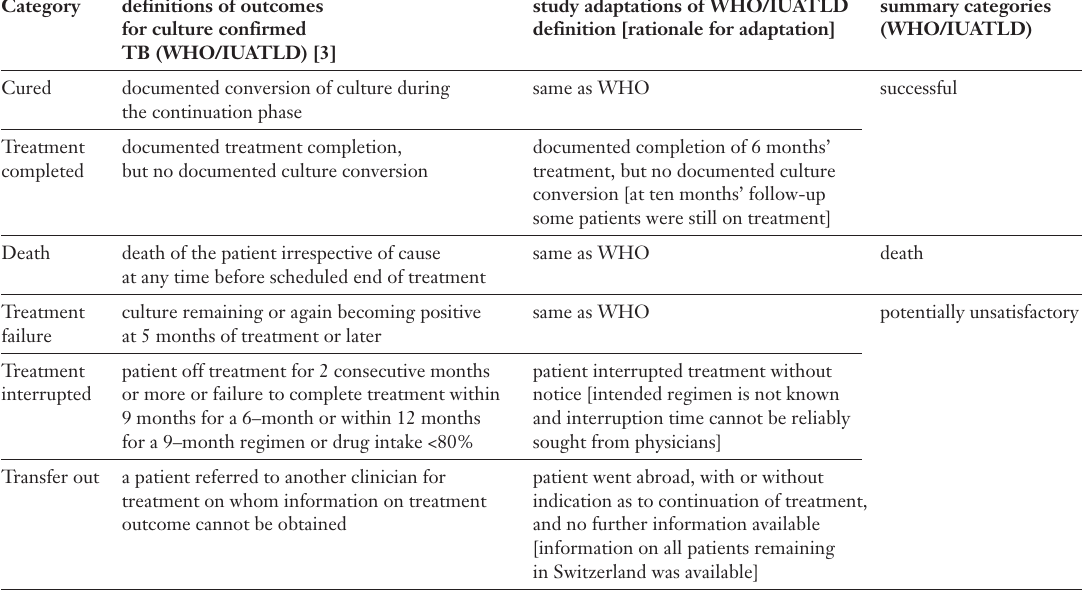
Outcome categories and